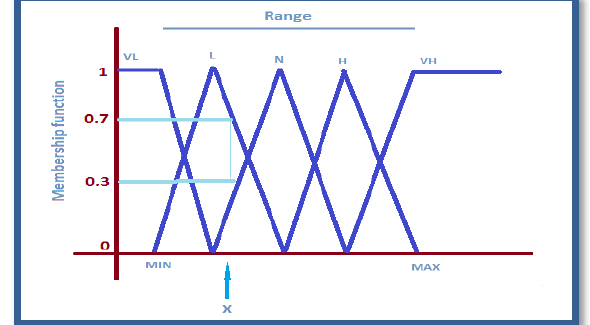
Fig. 3. Fuzzy sets of Membership function ( μ ) and corre- sponding fuzzy